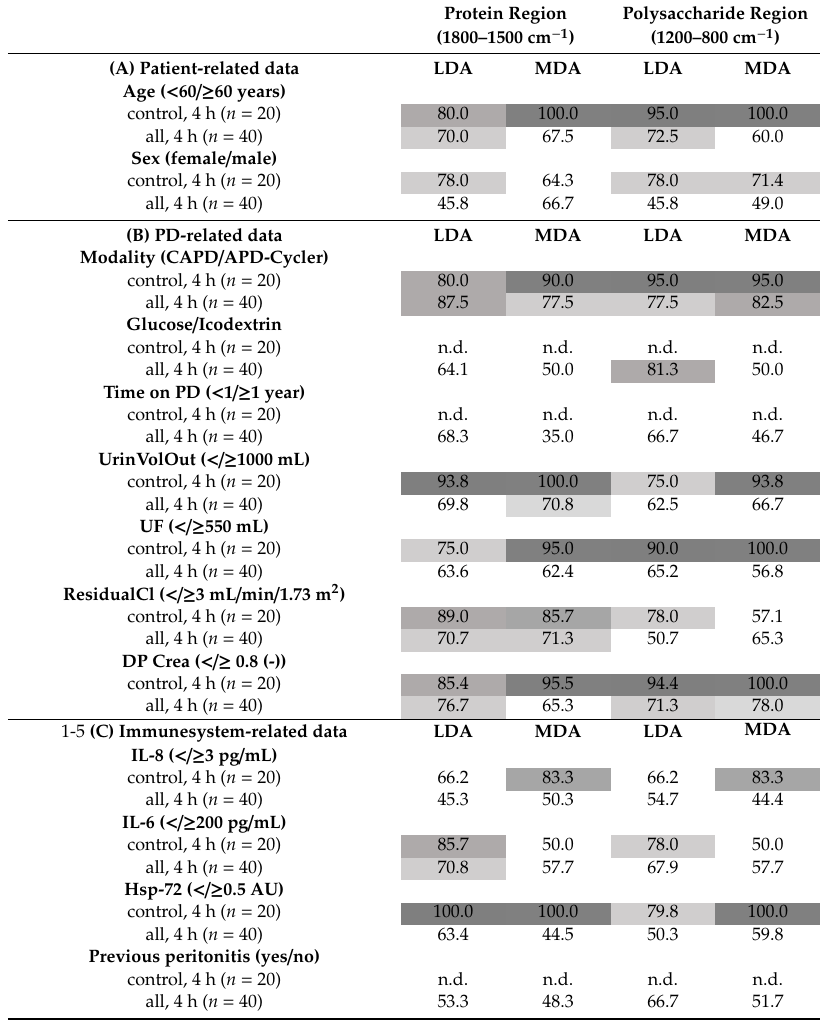
Table 2. Classification rates (%). The gray scale is according to the classification rates to instantly overview the top-performing combinations of all variable data parameters (classification rates: ≥ 70%, light gray; ≥ 80%, gray and ≥ 90%, dark